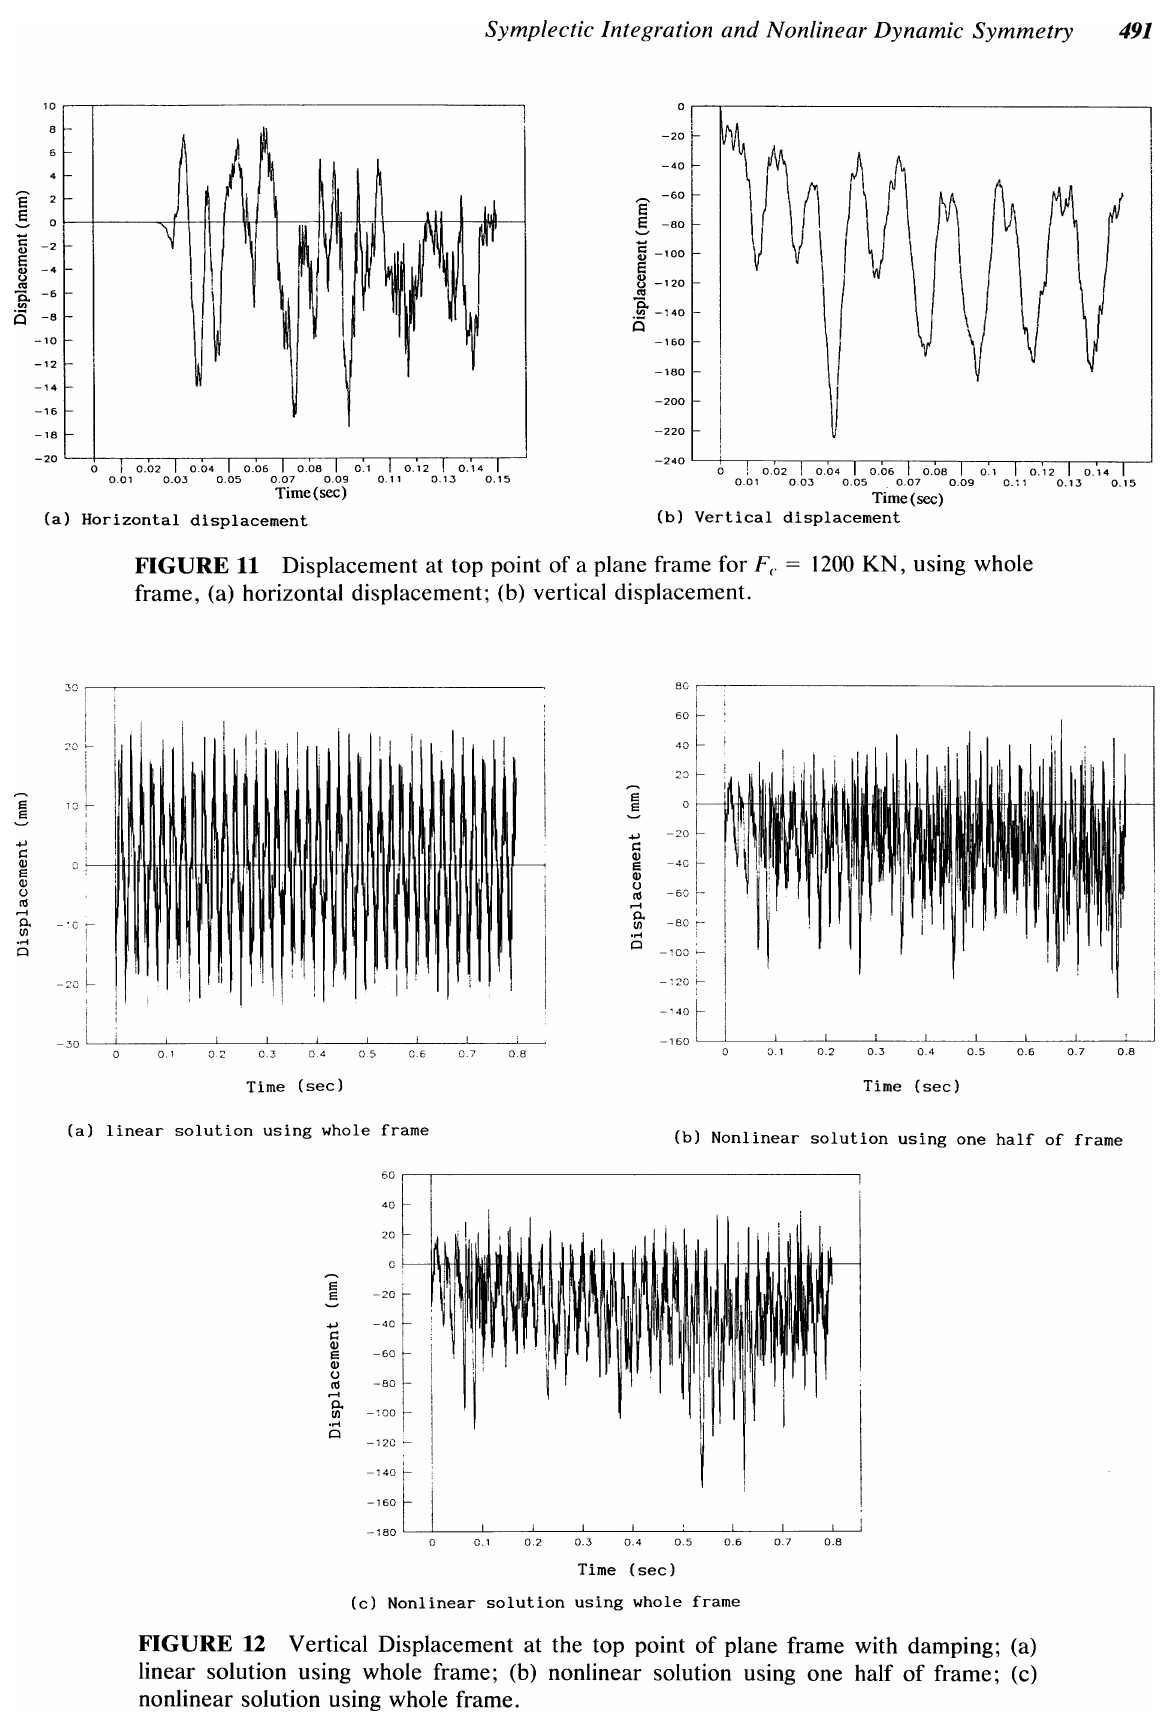
FIGURE U Vertical Displacement at the top point of plane frame with damping; (a) linear solution using whole frame; (b) nonlinear solution using one half of frame; (c) nonlinear solution using whole